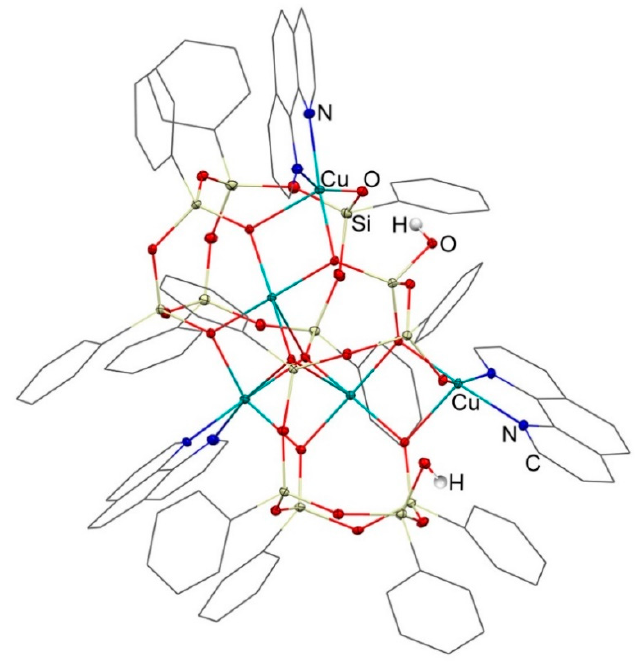
Figure 1. Top left: Molecular structure of 1. Top right: Molecular structure of cage metallasilsesquioxane (CLMS) from ref. 8b. Solvating molecules of THF are not shown for clarity. Bottom left: Structure of silsesquioxane Si 12 -ligand in 1. Bottom right: Structure of silsesquioxane Si 12 - ligand in CLMS from ref.